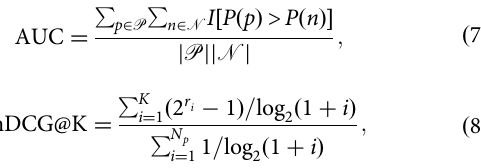
Algorithm 1 . Training algorithm of our